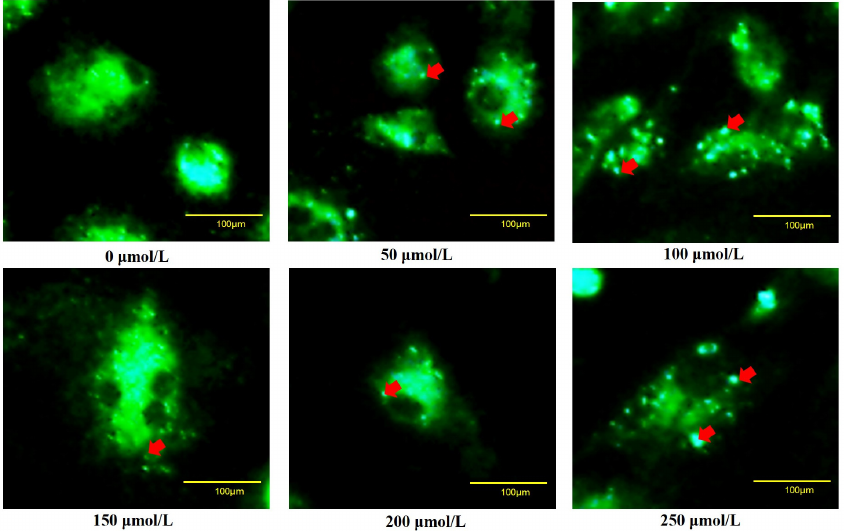
Figure 7. In vitro H 2 O 2 − induced oxidative stress model. ( A ) State and viability of goose GCs treated with different concentrations of H 2 O 2 (0, 50, 100, 150, 200 and 250 µ mol/L). ( B ) Cell death was assessed after H 2 O 2 treatment for 12 h by LDH release assay. ( C ) After GCs were incubated with various concentrations of H 2 O 2 for 12 h, the viability of the cells was determined by CCK-8 assay ( n = 3). ( D ) GCs were incubated with 100 μ mol/L H 2 O 2 for 24, 48 and 72 h, and the viability of the cells was determined by CCK-8 assay ( n = 3) and compared with that of cells treated with 100 μ M H 2 O 2 for various durations. The values are expressed as the means ± standard errors; ** indicates an extremely significant difference ( p < 0.01).